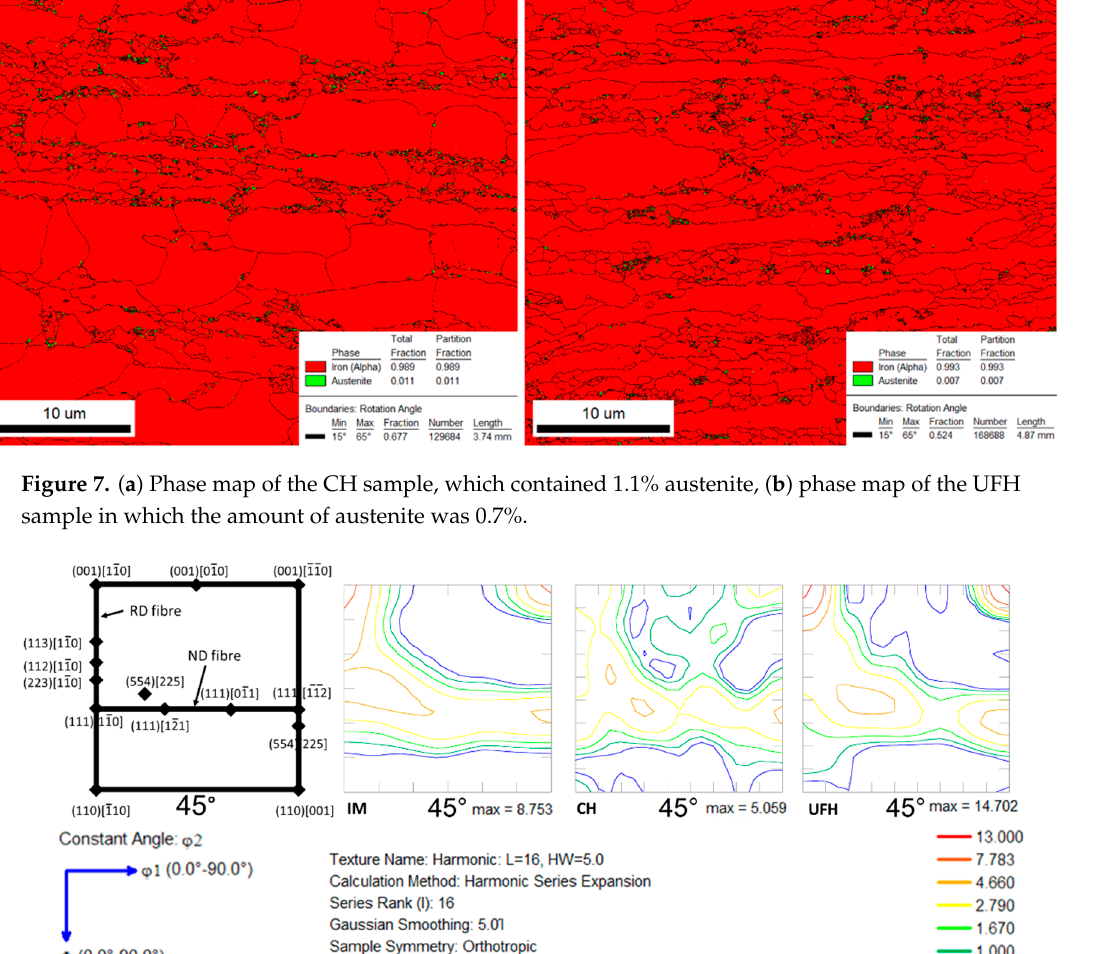
Figure 9. The grain average misorientation (GAM) map for the ( a ) CH and ( c ) the UFH sample including the low angle grain boundaries (LAGBs; 5–15°, red lines). Recrystallization of ferrite is expected to result in lower grain average misorientations and appear in blue with no LAGBs. Recovered ferrite and martensite appear in green and LAGBs are included in the grains. Supplementary kernel average misorientation (KAM) maps for the ( b ) CH and ( d ) UFH show the local misorientation due to dislocations present in the lattice. Recrystallized ferrite appears with much lower dislocation density than recovered ferrite and martensite.